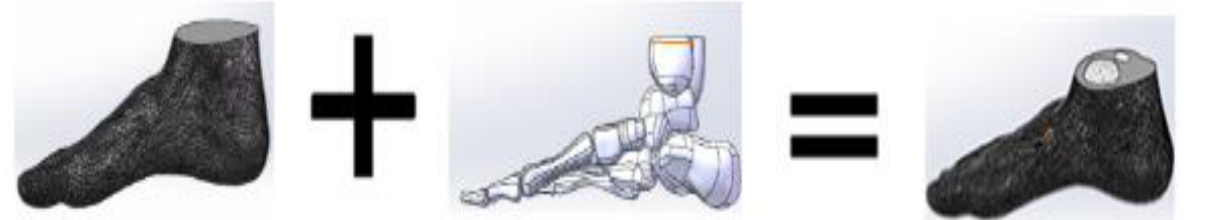
Figure 2. Model construction diagram.